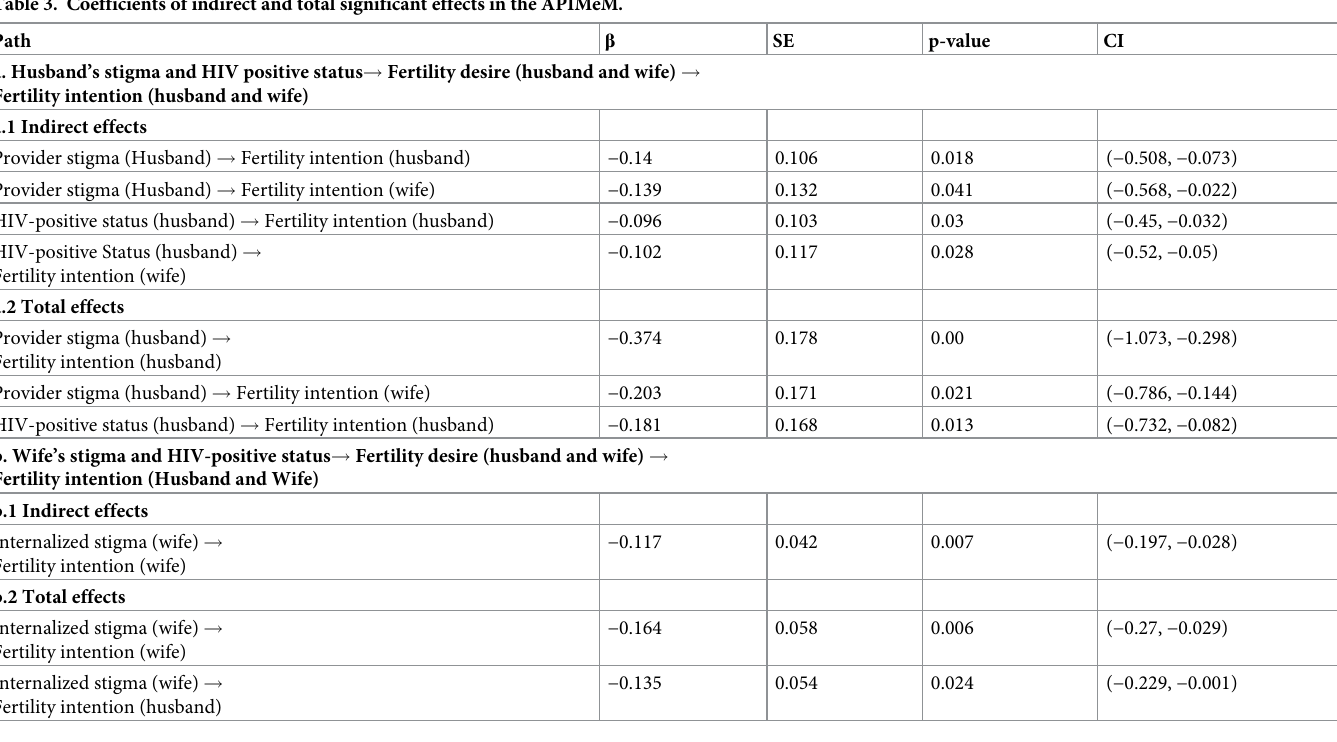
Table 3. Coefficients of indirect and total significant effects in the